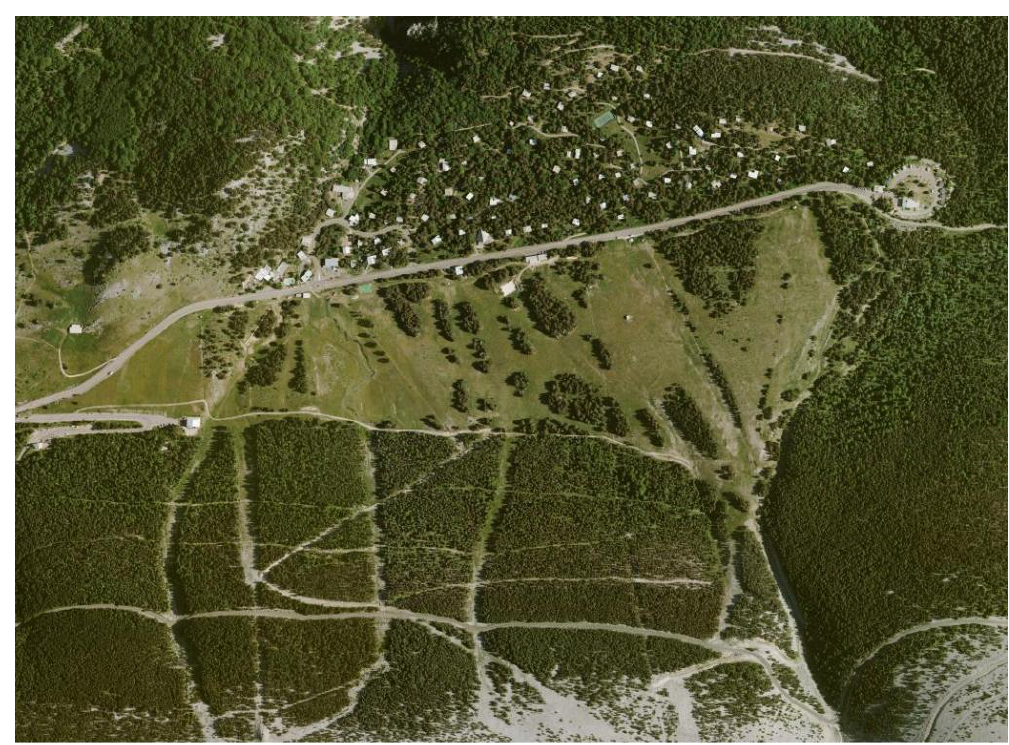
Figure 2. Aerial photography of the Mont Ventoux (southern